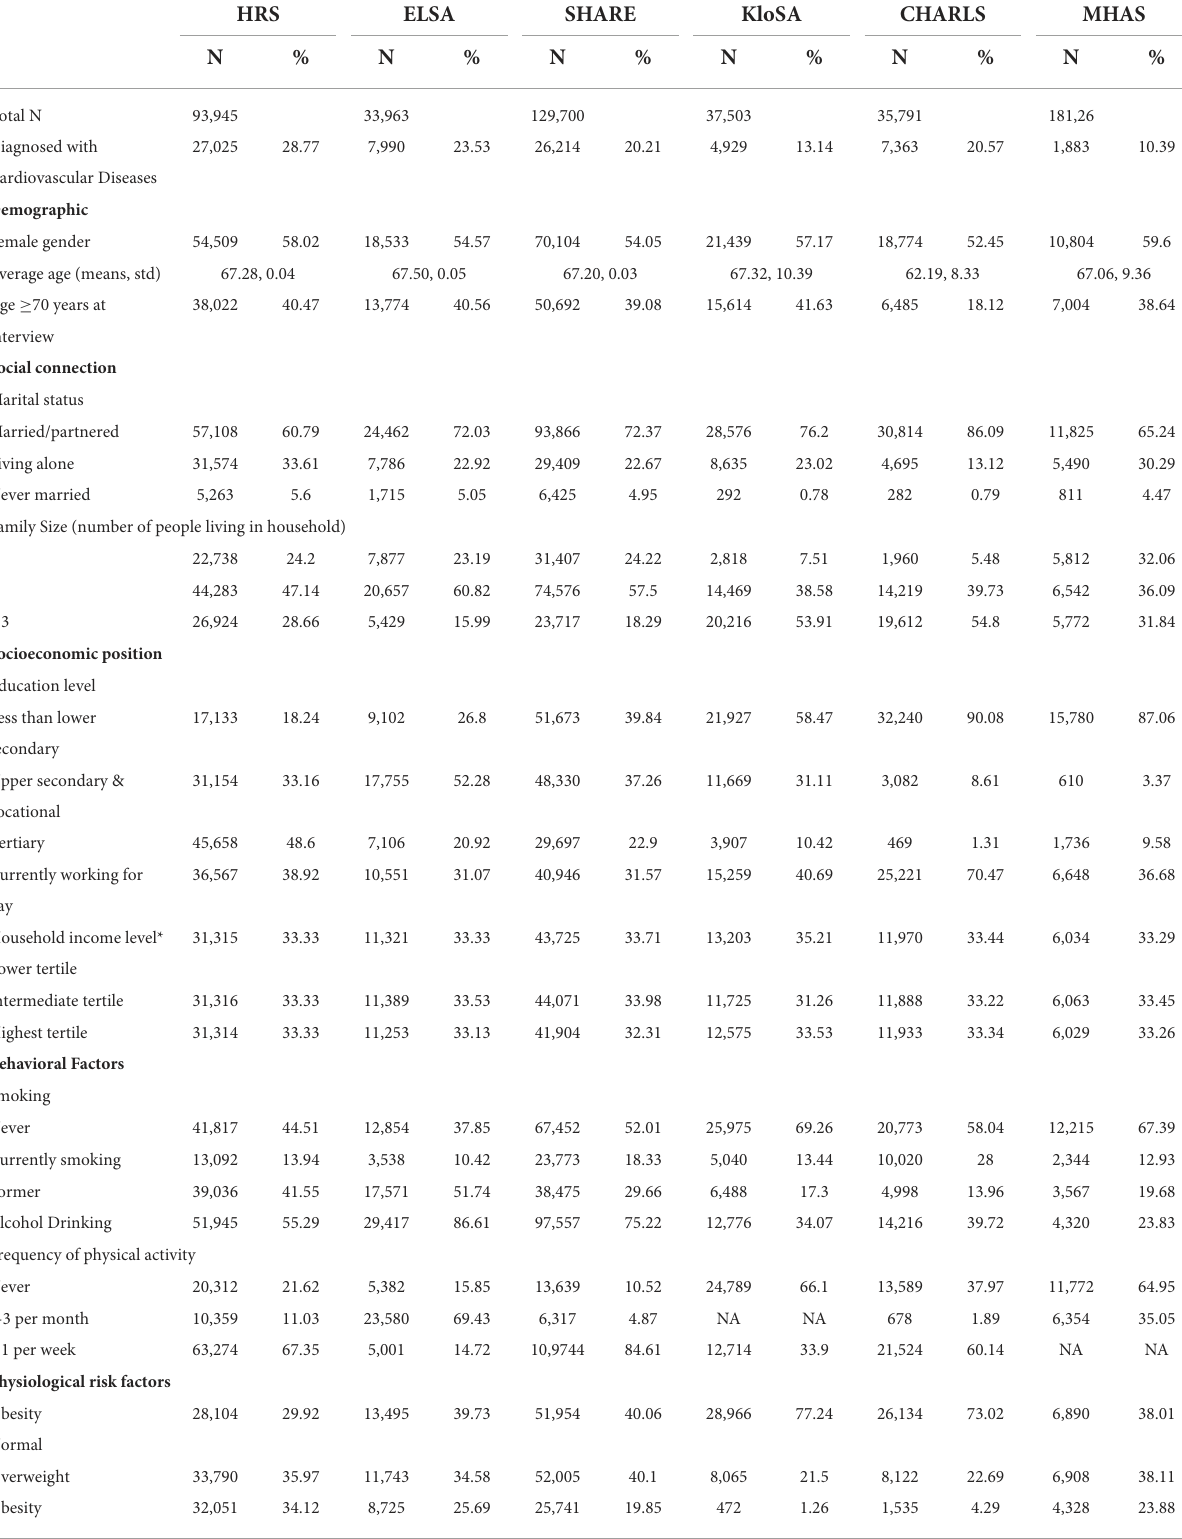
TABLE 1 Variables included in the present analysis with summary statistics by cohort